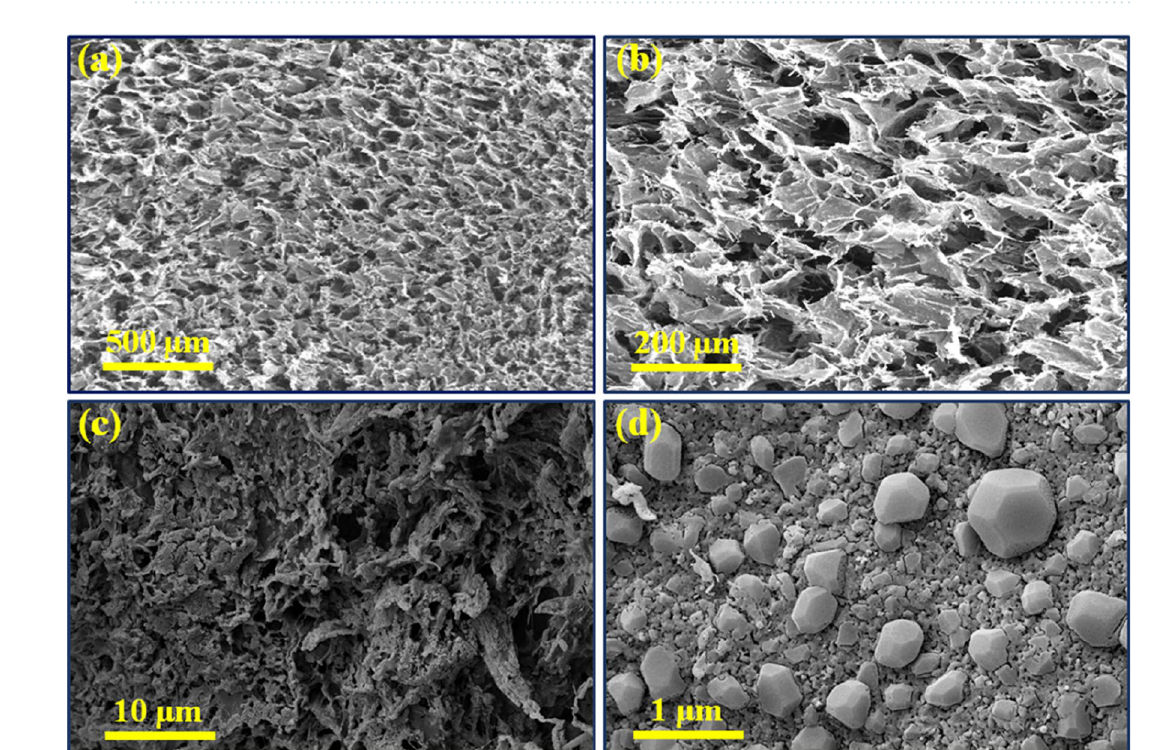
Figure 4. FE-SEM images of ( a , b ) CTT-CS hydrogel, ( c ) CTT-CS/SF hydrogel, ( d ) synthetic CTT-CS/SF/